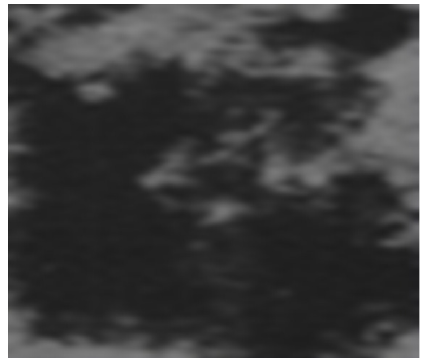
blue box represents the area of interest.